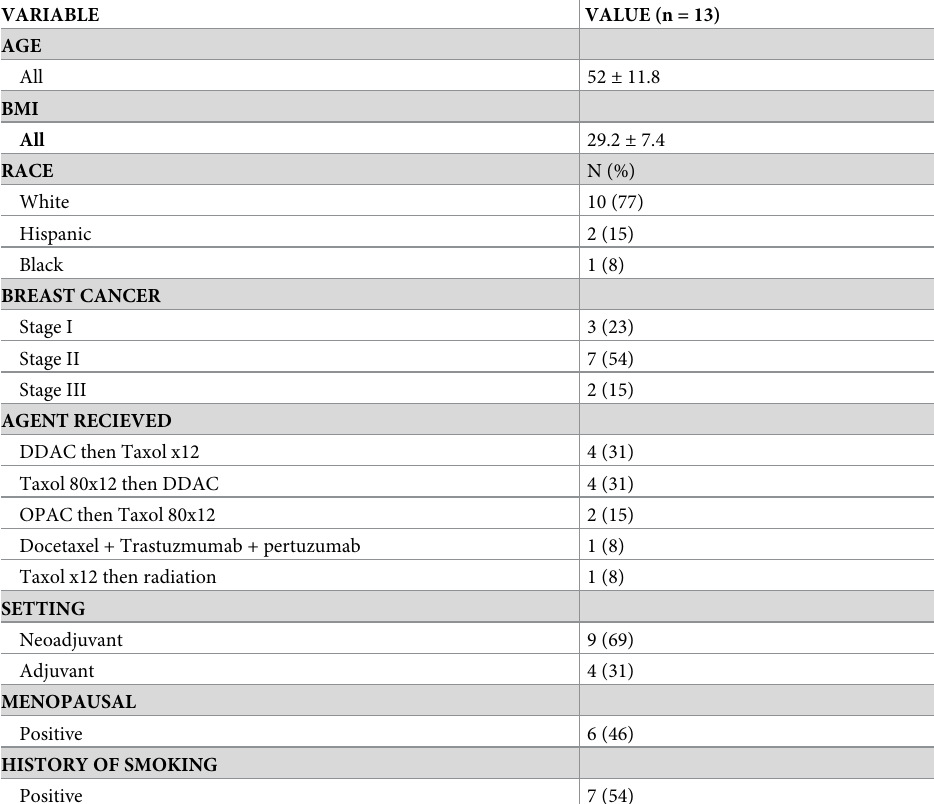
Table 1. Breast cancer patient characteristics (n =